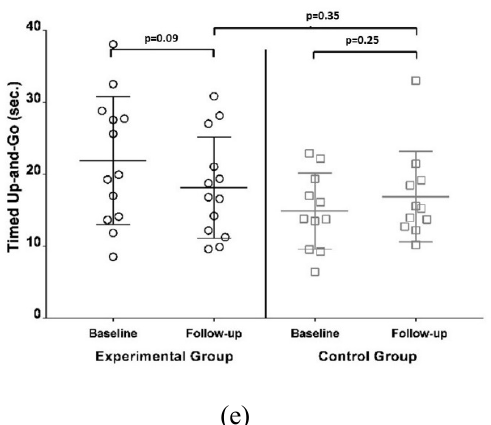
Figure 1. Functional ability scores in the control group and the intervention group at baseline and post intervention. ( a ): Handgrip Strength; ( b ): 4 Stage Balance Test “Modified”; ( c ): Step Test; ( d ): 30s Sit ‐ To ‐ Stand; ( e ) Timed Up and Go.